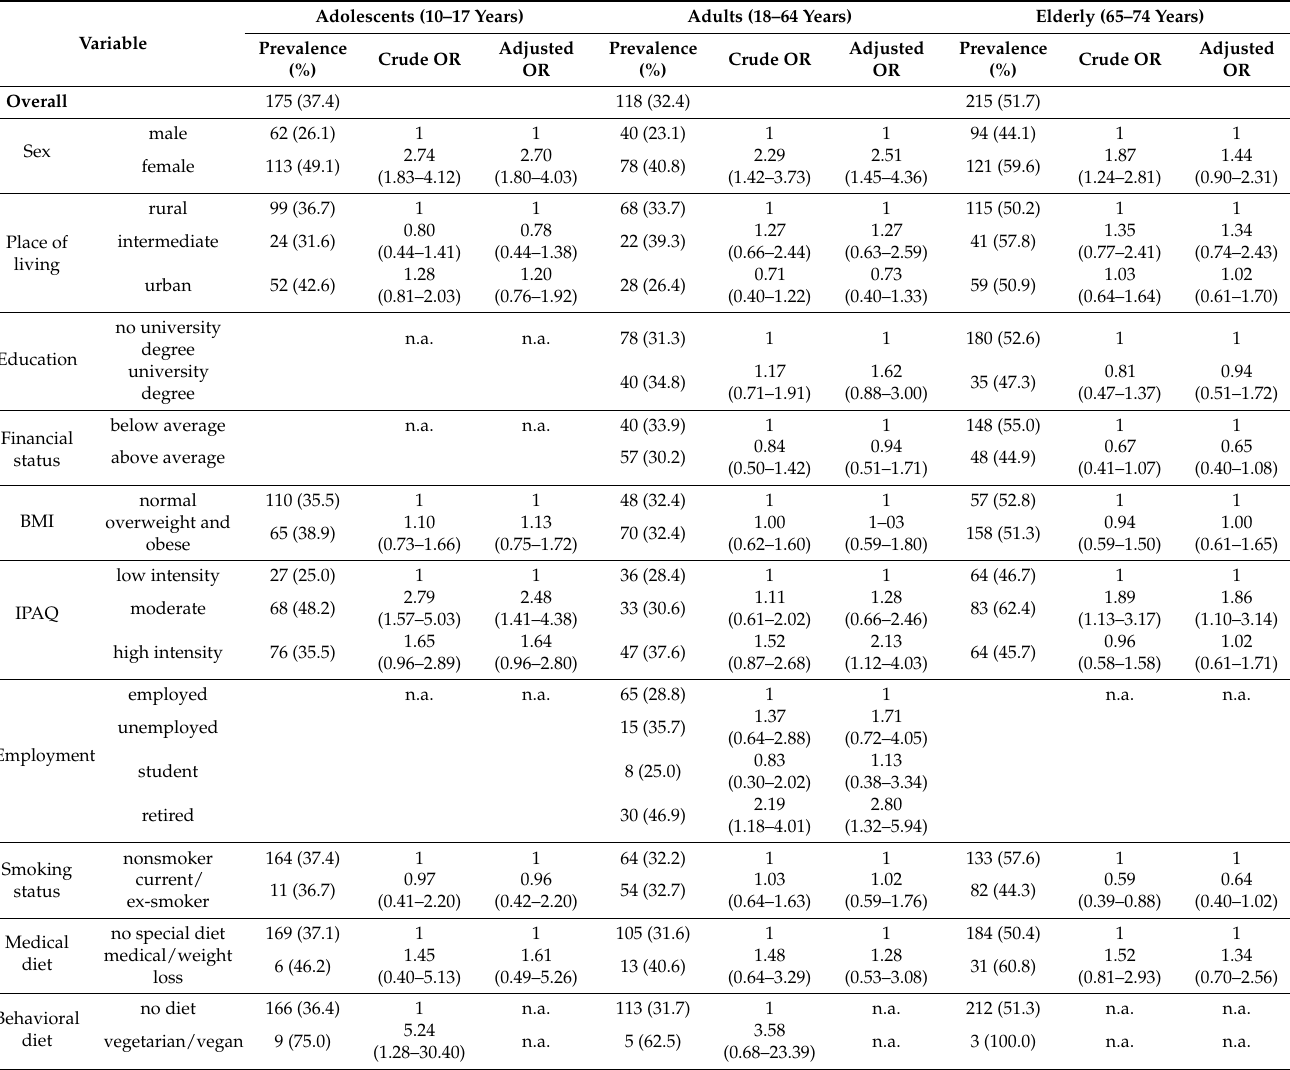
Table 3. Association between the prevalence of inadequate intake of vitamin B12 (<4 µ g/day) and sex, place of living, education, income, employment, smoking status, BMI, IPAQ, vegetarian/vegan diet, and diet restrictions for different age